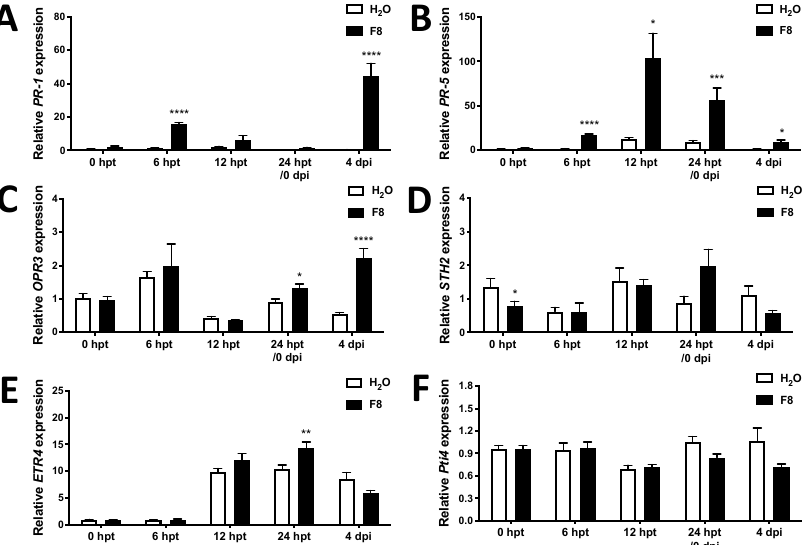
Figure 4. The expression of phytohormone-mediated immune marker genes in F8-culture filtrate or H 2 O pretreated Yu-Nu tomato before or after TYLCTHV inoculation. Tomato plants were pretreated with H 2 O or F8-culture filtrate and inoculated with TYLCTHV using whitefly vector at 24 hpt. The relative expression of SA-responsive gene PR-1 ( A ) and PR-5 ( B ), jasmonic acid (JA)-biosynthesis gene OPR3 ( C ), JA-responsive gene STH2 ( D ), and ethylene (ET)-responsive gene ETR4 ( E ) and Pti4 ( F ) were detected by qRT-PCR at 0, 12 and 24 hpt or at 4 dpi. β -actin was used as an input control. Data are mean ± SEM of 3 biological replicates. Student’s t -test was used for comparative analysis of the data for the H 2 O and F8-culture filtrate pretreated groups. * p < 0.05; ** p < 0.01, *** p < 0.005, **** p <